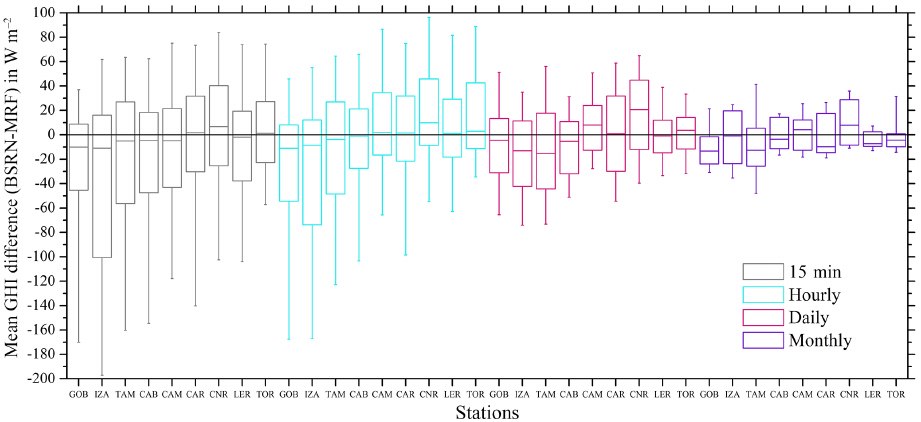
Figure 6. Mean GHI differences in Wm − 2 derived by MRF as compared to the BSRN stations for each time horizon. The boxes represent the 25th and 75th percentiles, while the in-box lines represent the median of the difference of each station. The upper and lower whiskers represent the minimum and maximum error